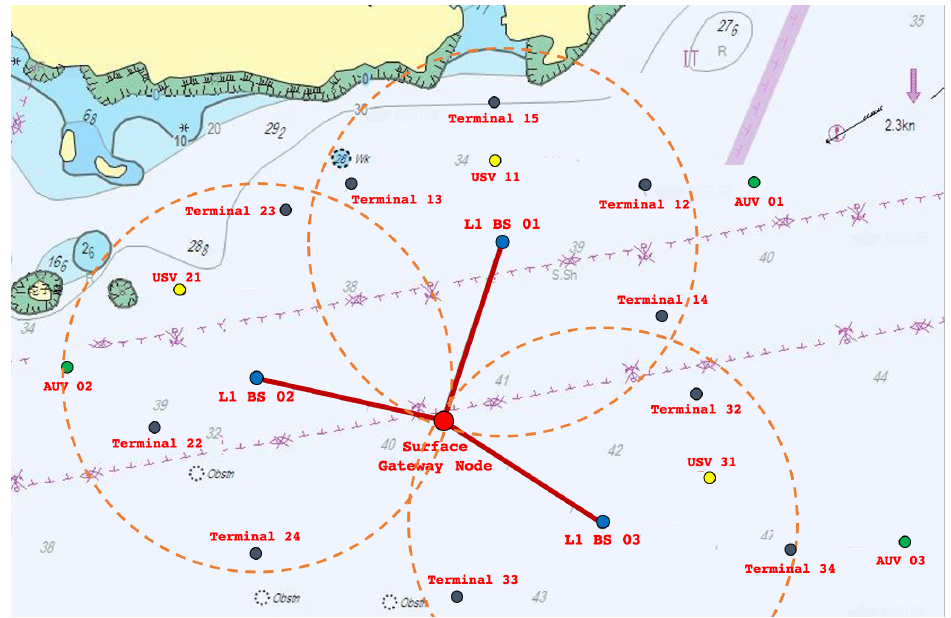
Figure 10. The area of uw -Cellular network deployed.